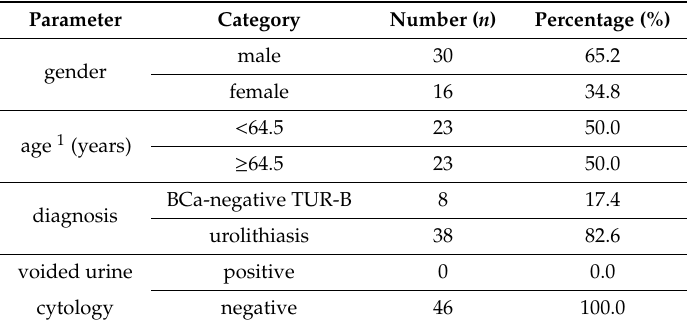
Table 2. Demographic, clinical, and histopathological characteristics of the control subjects. The control group was comprised of 46 subjects in total, whereupon eight patients were histopathologically negative for BCa at TUR-B and 38 patients had urolithiasis. The table shows the absolute and relative distribution of gender, age and clinicopathological